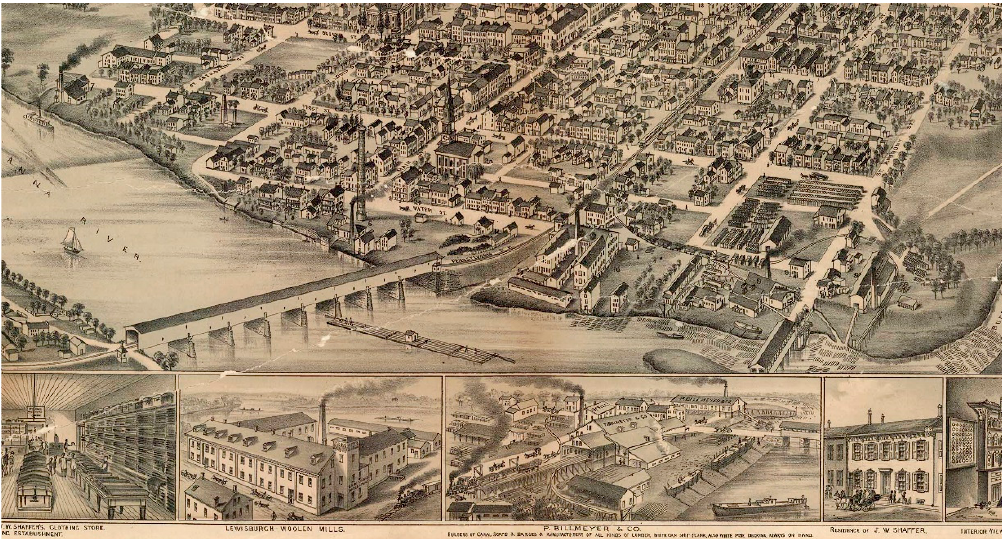
Figure 2. Detail from a bird’s-eye rendition of the waterfront at Lewisburg in 1884